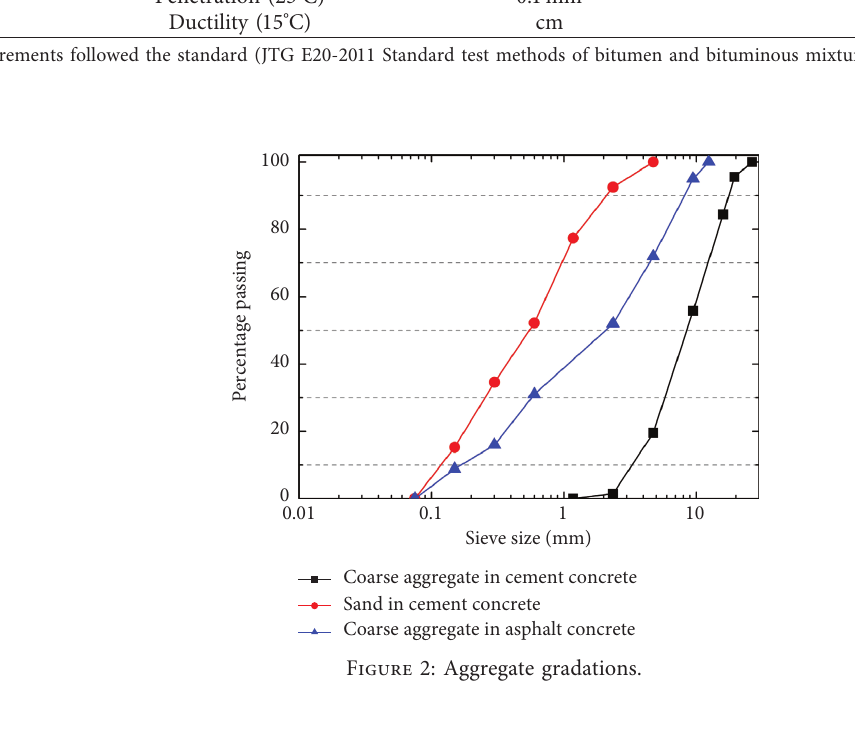
Table 3: Mixture design of cement concrete.